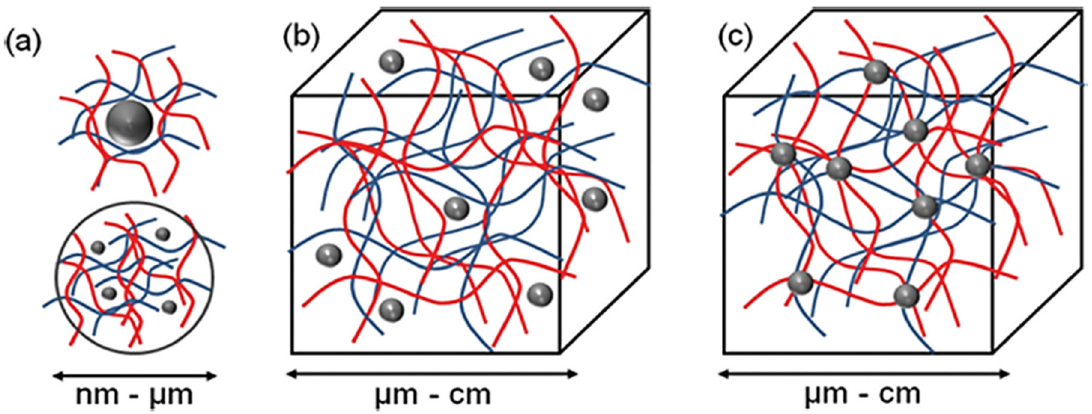
Figure 4. The concept for a combination of NLC and hydrogel to form new functional materials. Three different structural designs exist: ( a ) nano-sized hydrogel particles stabilizing inorganic or polymer NLC ( b ) NLC non-covalently immobilized in a hydrogel matrix and ( c ) NLC covalently immobilized in hydrogel matrix (Adapted from [1]).